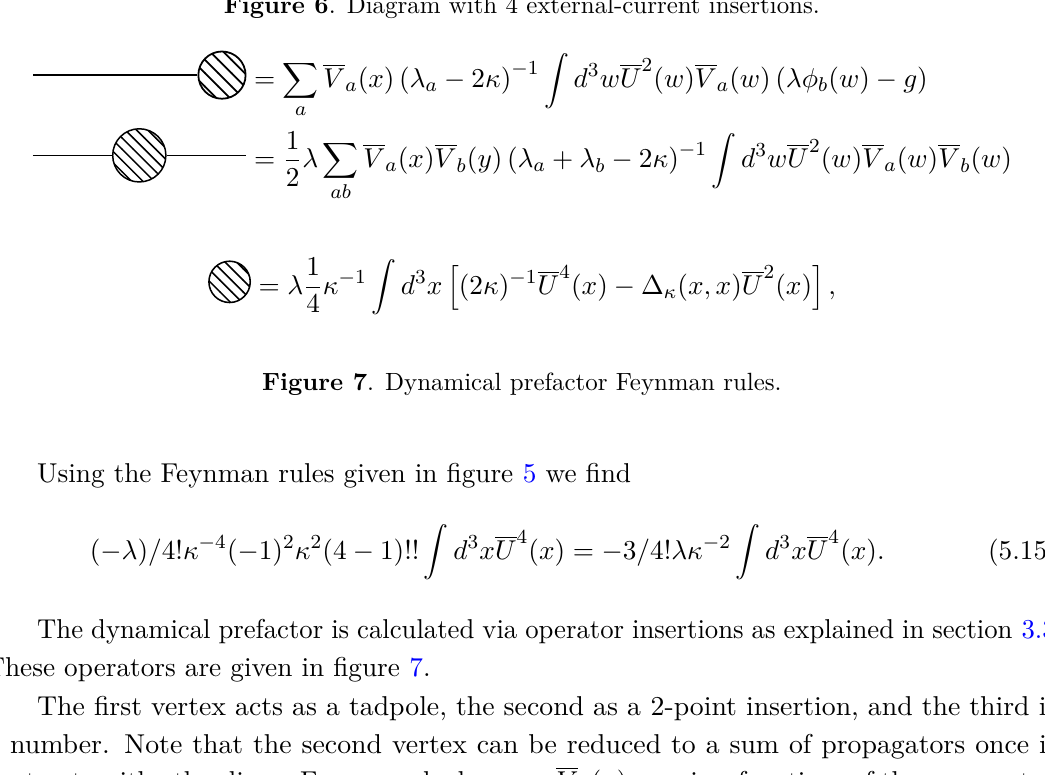
Figure 6 . Diagram with 4 external-current insertions.